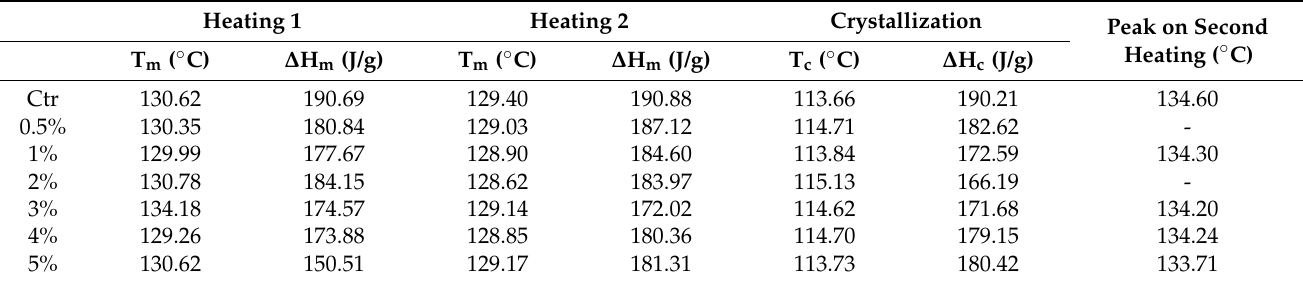
Table 2. DSC analysis results for samples containing biocide with a concentration of 0.5–5% and for control samples—without biocide